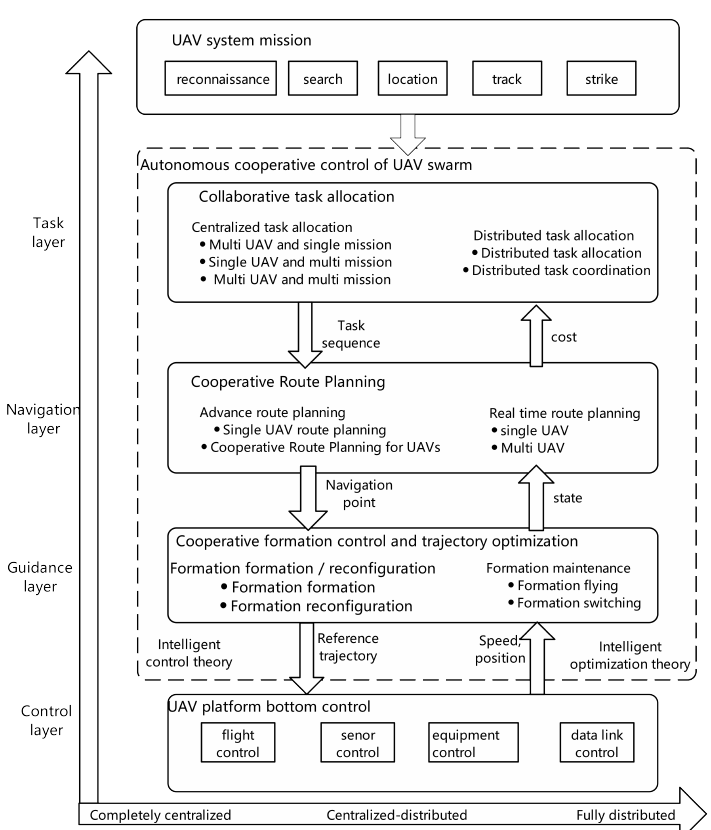
Figure 12. The hierarchical